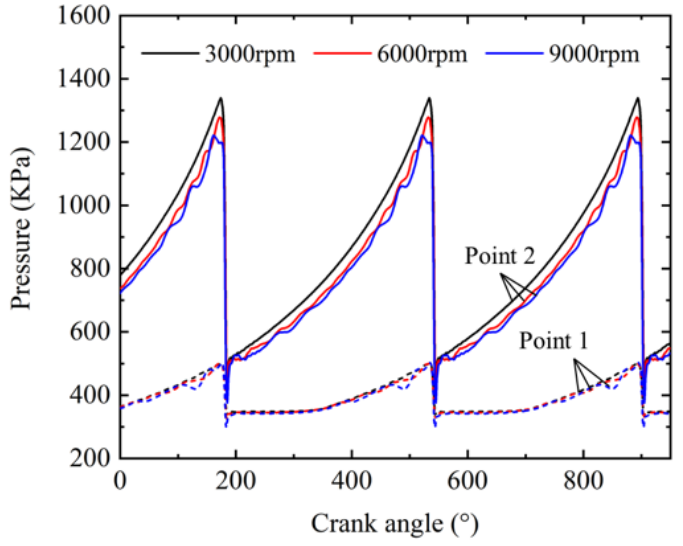
Figure 10. The pressure lines at monitor points 1 and 2 in the working chamber.